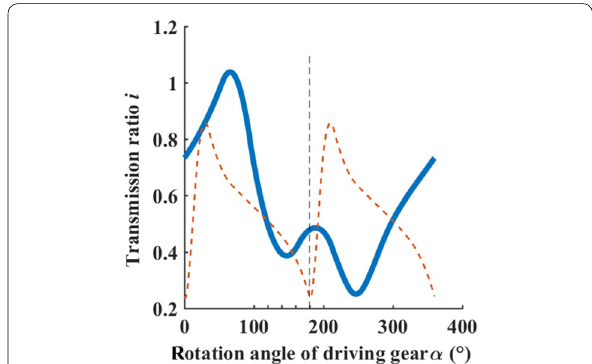
Figure 5 Transmission ratio of the symmetrical and asymmetrical second-order non-circular gear